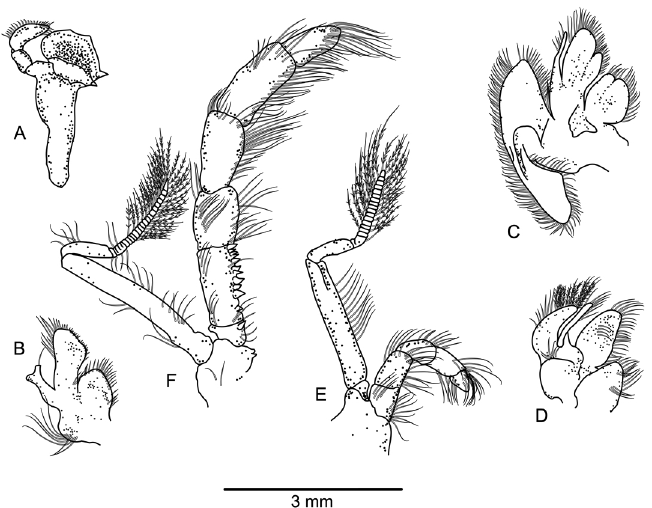
Figure 3. Paragiopagurus atkinsonae sp. n., South Africa, West Coast, male paratype 7.0 mm, WCDSS2015 (USNM 1292084). Left mouthparts, internal view. A mandible B maxillule C maxilla D first maxilliped E second maxilliped F third